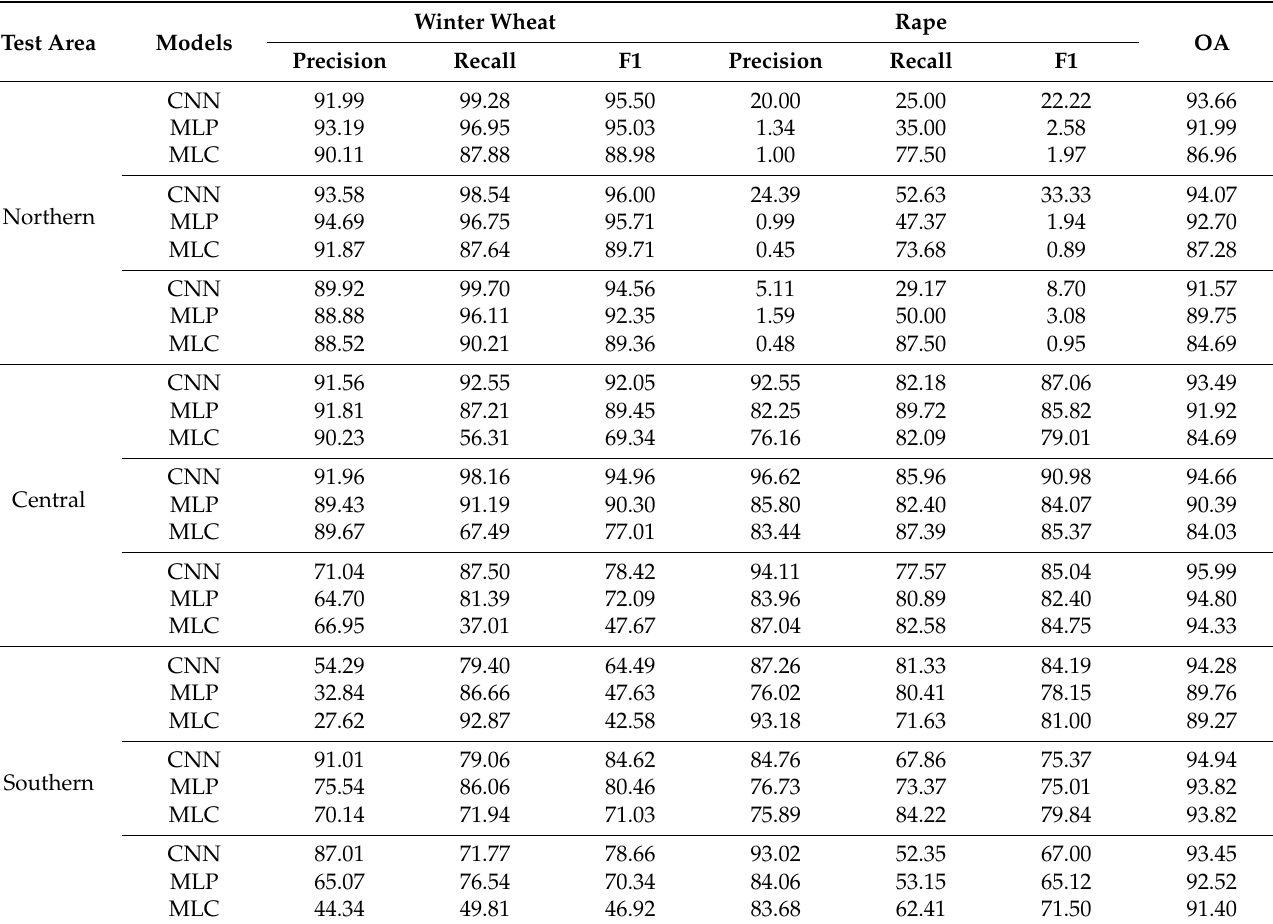
Table 13. Results of the correlation method to identify winter wheat on GF-6